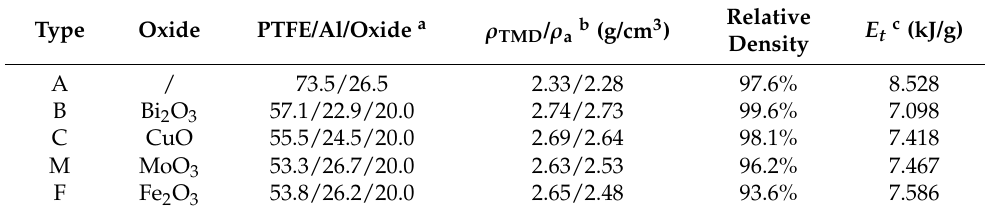
Table 2. Specific information of PTFE/Al/oxide.